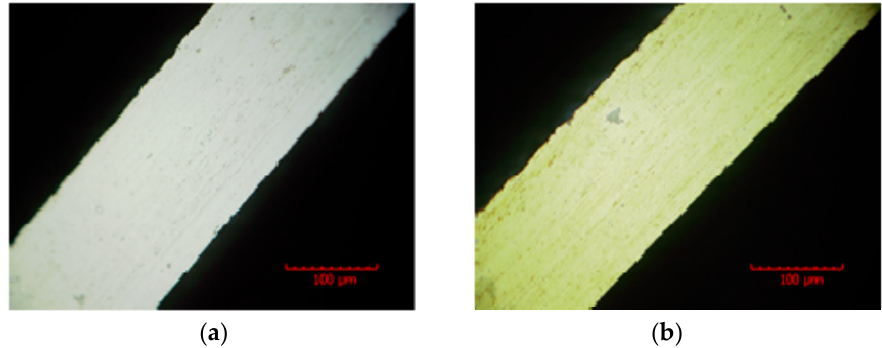
Figure 7. Comparison of morphology of pure aluminum rectangular mandrel before and after gold puttering: ( a ) Leica example before gold puttering, ( b ) Leica example after gold puttering. After the gold sputtering was completed, gold electroplating was carried out on the surface of the gold sputtered layer. The morphological observation results are shown in Figure 8. The gold layer on the surface of the aluminum sacrificial mandrel was dense, and the gold layer surface was free of defects such as pores and nodules. After the gold plating, a copper electroforming experiment was carried out on the surface of the gold layer. The morphological observation results are shown in Figure 9.